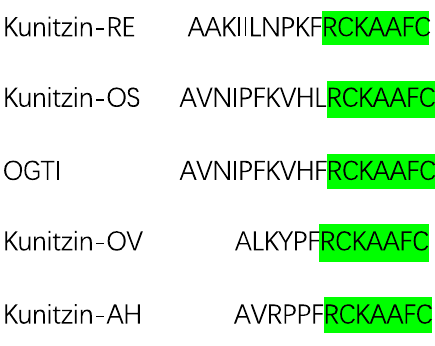
Figure 1. The mature peptide sequence of Kunitzin-AH from the skin secretion of Amolops hainanensis compared with previously identified kunitzins. Fully conserved domains were marked in green.